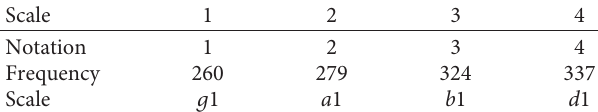
Table 1: Scale and frequency